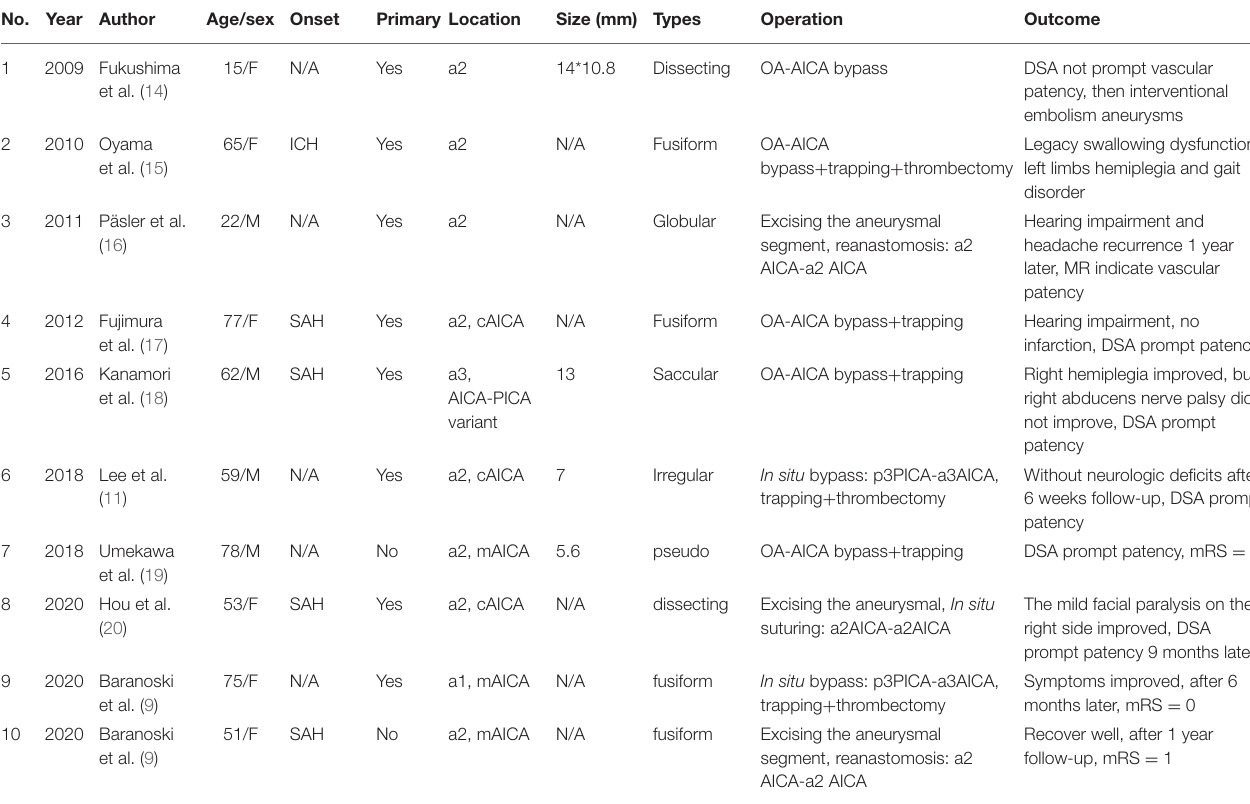
TABLE 1 | Literature review of AICA aneurysms treated by vascular